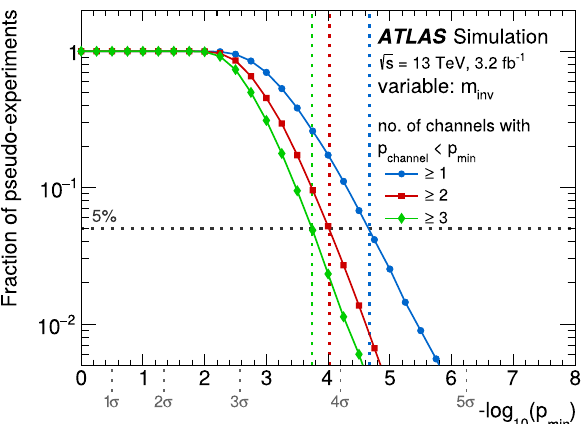
Fig. 1 The fractions of pseudo-experiments ( P exp , i ( p min ) ) in the m inv scan, which have at least one, two or three p channel -values smaller than a given threshold ( p min ). Pseudo-datasets are generated from the SM expectation. Dotted lines are drawn at P exp , i = 5% and at the corre- sponding − log 10 ( p min )